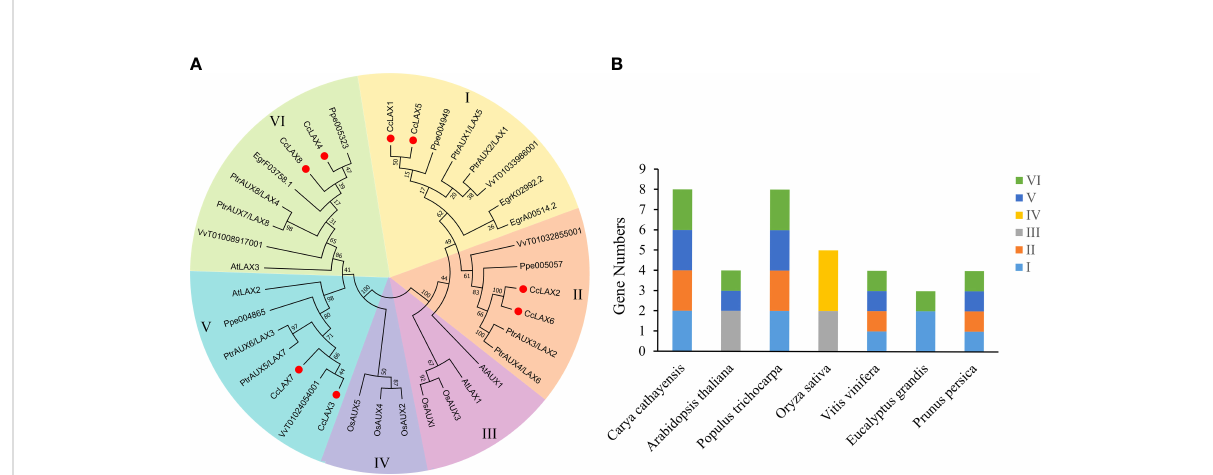
FIGURE 1 Phylogenetic analysis of CcAUX/LAX family genes with other AUX/LAX genes from 6 species. (A) The phylogenetic tree.The unrooted phylogenetic tree was built in MEGA6 using the neighbor-joining (N-J) method, and the bootstrap values were calculated using 1000 iterations. Different colored backgrounds indicate different groups. (B) The number and distribution of AUX/LAXs in different species. At, Arabidopsis thaliana ; Pt, Populus trichocarpa ; Os, Oryza sativa ; Vv, Vitis vinifera ; Eg, Eucalyptus grandis ; Pp, Prunus persica .